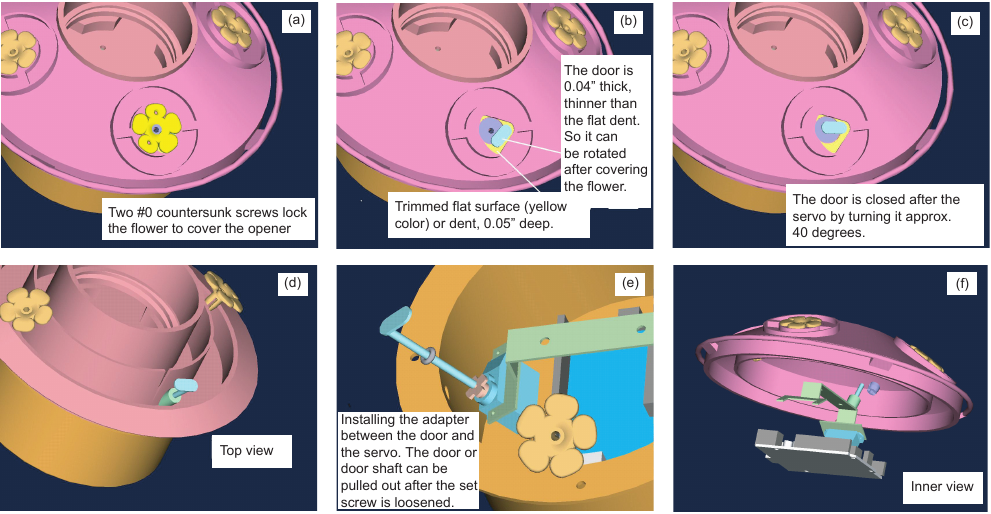
Figure 7. Computer aided design models of installing custom feeder opener on an off-the-shelf hummingbird feeder. The main steps include ( a ) modifying the flower opening; ( b ) resurfacing the area beneath the flower opening; ( c ) and ( d ) installing the servo operated door; ( e ) connecting the door to the servo motor, and ( f ) installing the servo motor underneath the